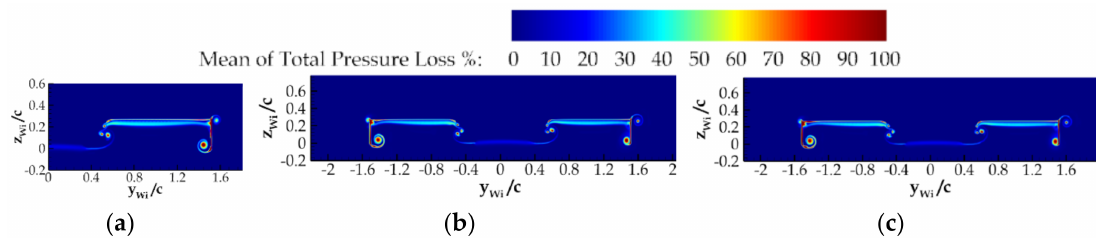
Figure 21. Contours showing the mean of the total pressure loss at x Wi /c = 1.019; the contour range has been capped to a maximum of 100% to improve the visibility of the wake. ( a ) Straight-line condition; ( b ) Cornering condition; ( c ) Fixed yaw condition.